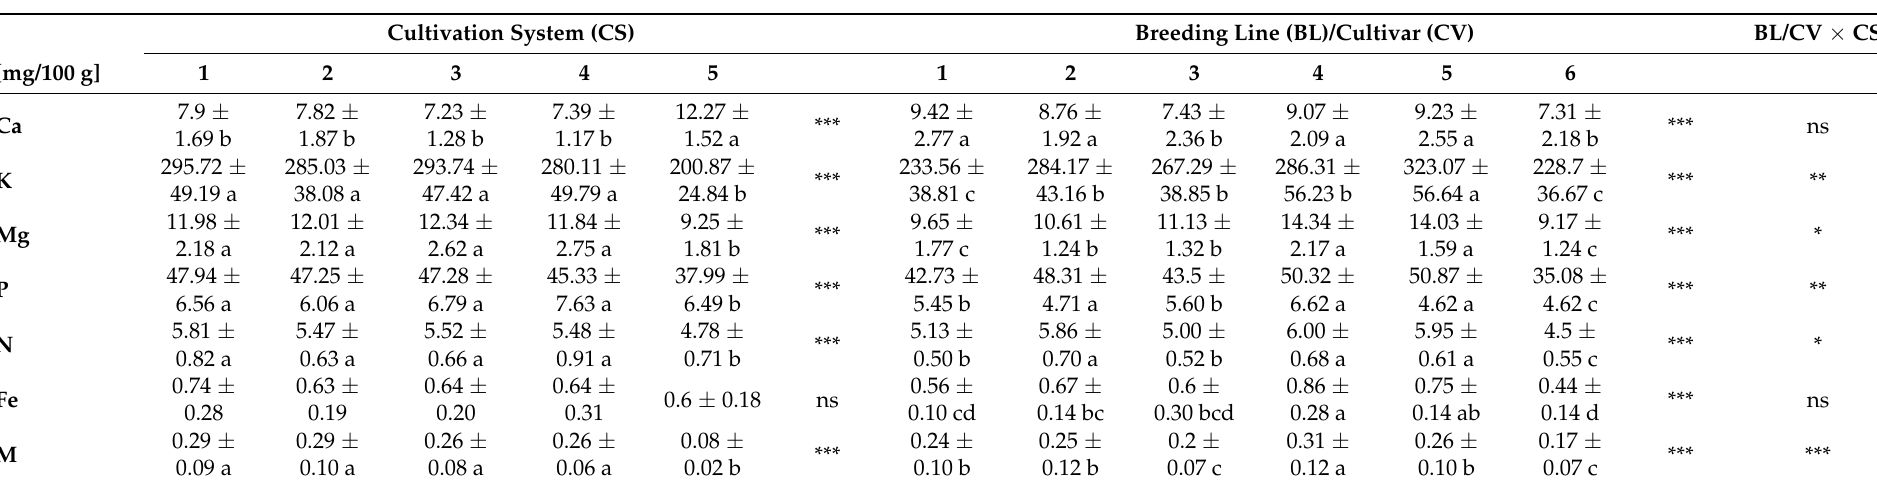
Table 4. Mean values ± standard deviation of minerals in five cultivation systems of five breeding lines and Lyterno F 1 , calculated on fresh matter basis. Cultivation System (CS) Breeding Line (BL)/Cultivar (CV) BL/CV ×